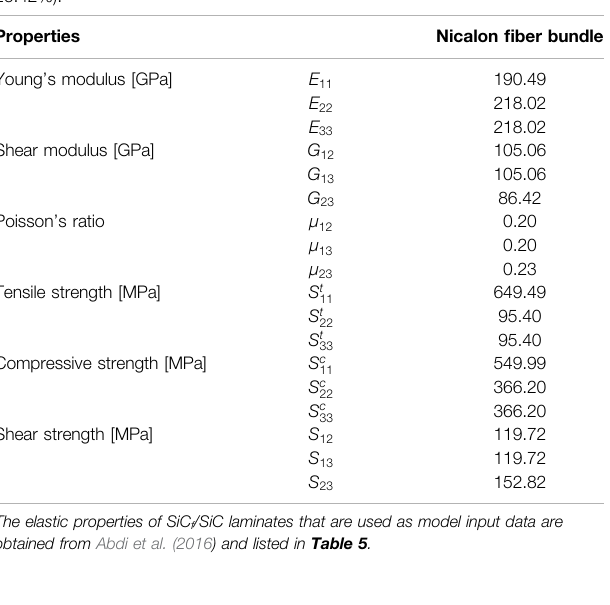
TABLE 3 | Mechanical properties of the fi ber bundle consolidated with the SiC matrix, calculated using Chamis ’ s equations ( fi ber volume fraction V f (cid:1)